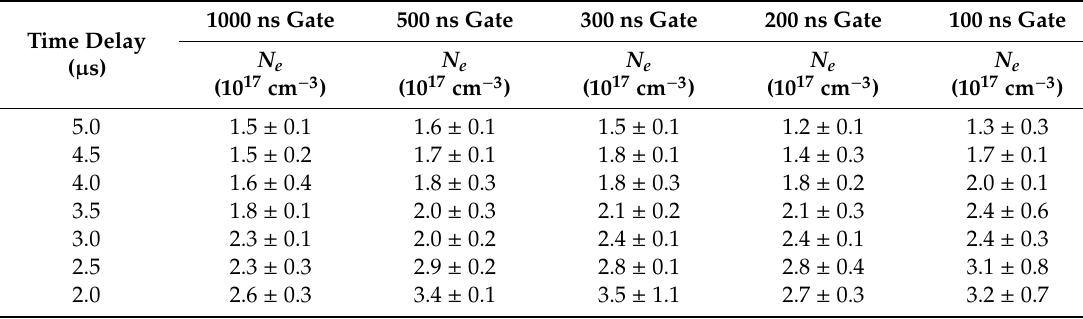
Table 2. Electron densities deduced from experimental values of Stark broadening of the H α -line obtained in the LSP experiments of this work.